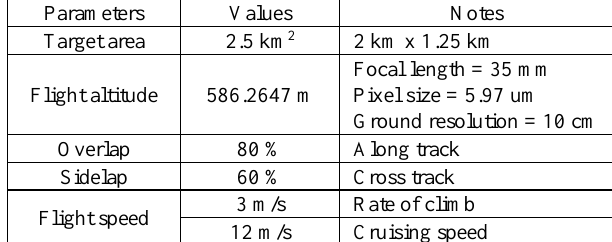
Figure 7. The distribution of GCP in the test